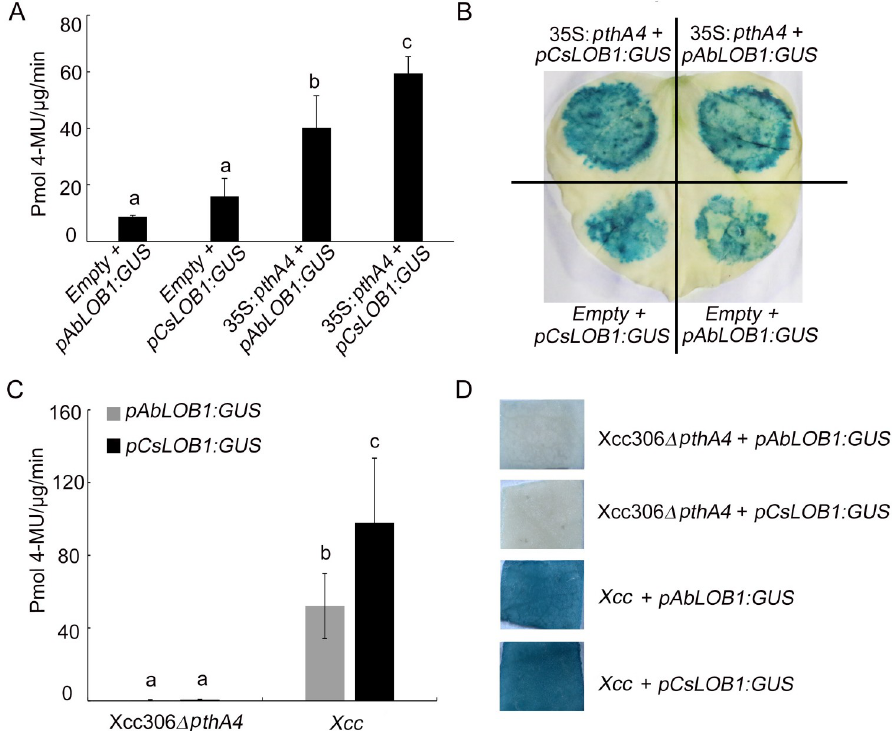
AbLOB1 and CsLOB1 induced by PthA4 in tobacco. (B) GUS staining assay in tobacco leaves. Agrobacteria containing pAbLOB1 : GUS or pCsLOB1 : GUS mixed with 35S: pthA4 or empty vector were infiltrated into tobacco leaves. Samples were collected at 2 days (Fig 7A and 7B). (C) Transient GUS activity related to pAbLOB1 and pCsLOB1 promoters after inoculation with Xcc or Xcc306 Δ pthA4 in sweet orange. Samples were collected for further analysis at 4 days post inoculation. (D) GUS staining assay of sweet orange leaves upon ectopic expression of pAbLOB1 : GUS or pCsLOB1 : GUS post inoculation with Xcc or Xcc306 Δ pthA4 . Error bars indicate standard deviation of three independent replicates. Different letters above the bars represent significant differences (P < 0.05) in Duncan’s multiple range